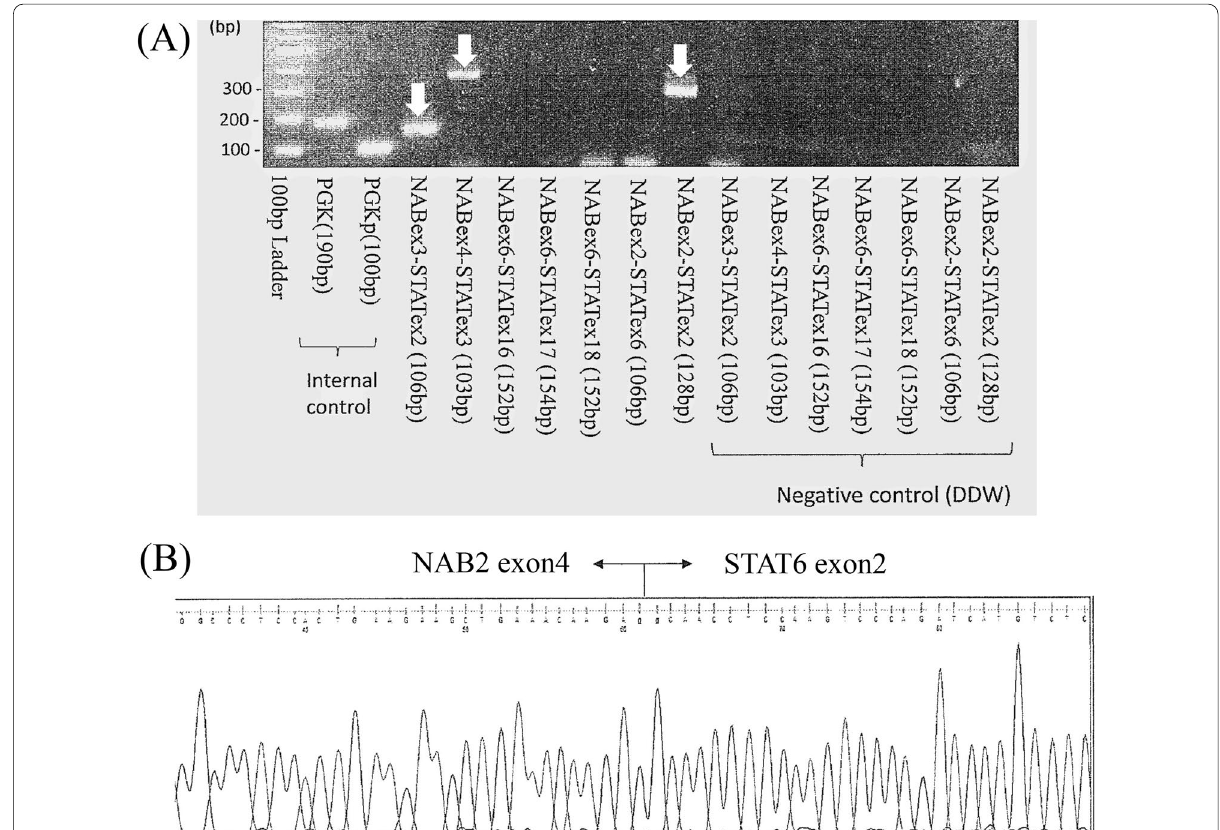
Fig. 3 The NAB2 and STAT6 gene fusions (white arrows) are detected by reverse transcription-polymerase chain reaction ( A ). Direct sequence shows the NAB2 exon4-STAT6 exon2 gene fusion ( B